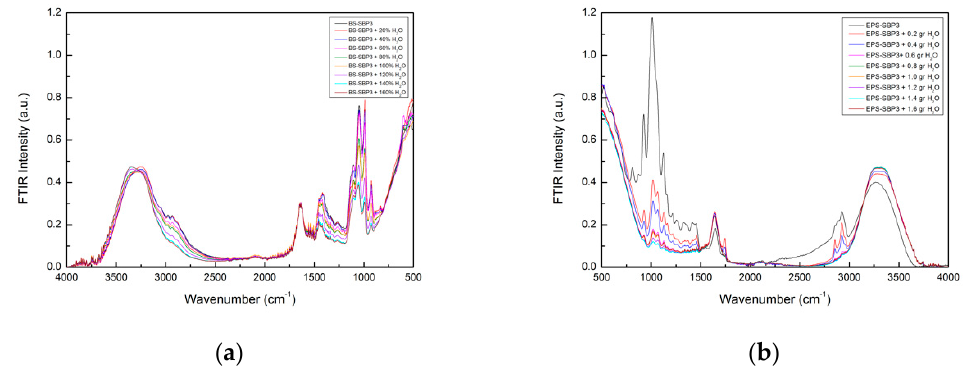
Figure 4. Infrared spectra for BS-SBP3 aqueous solutions ( a ) and EPS-SBP3 aqueous solutions ( b ) at different water concentrations in the spectral range 500–4000 cm − 1 .